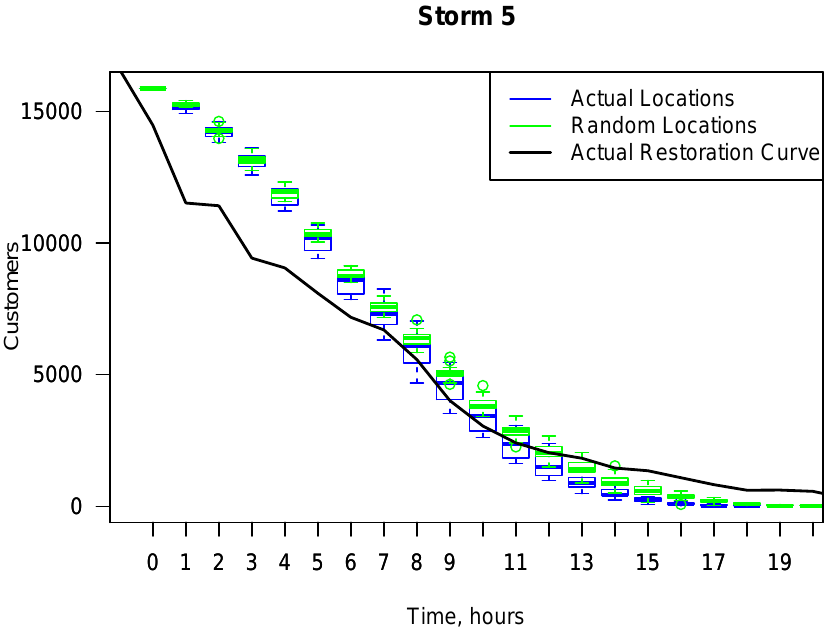
Figure 5. Comparison of actual and random outage locations for Storm 5. Crews start at area work centers and search for nearest outage. Travel speed set to 25 mph, 190 crews with 73% working during day shift, 100% working during evening shift and 100% working during night shift, 1 to 8 h repair time range. Storm 5 has 661 outages and 15,840 customers affected. The outages are located in the actual locations and then in random locations within Connecticut. The ETR curves were insensitive to outage